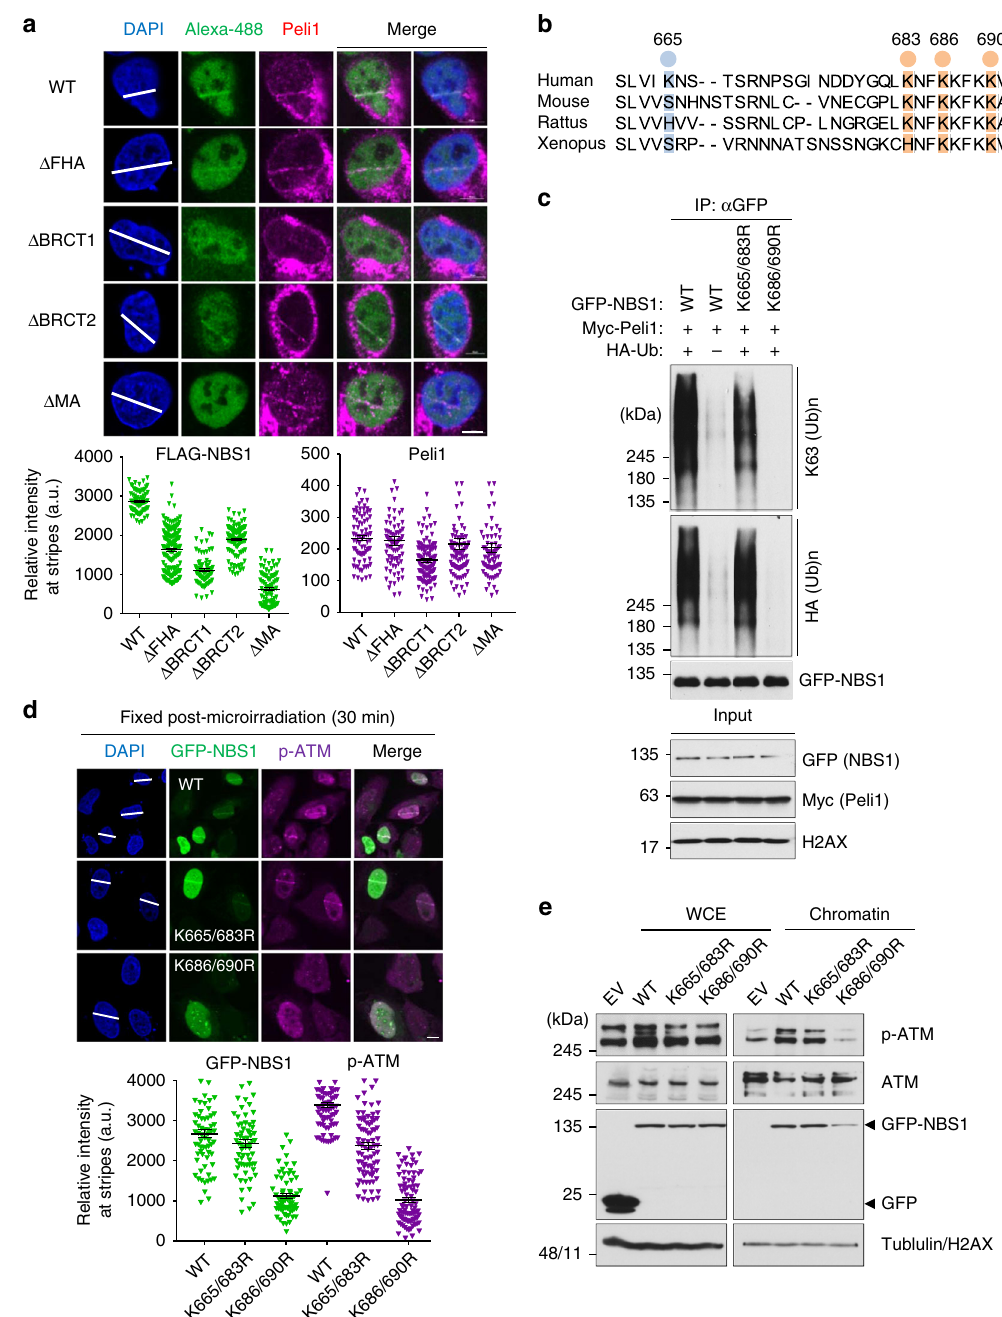
Fig. 7 Peli1 ubiquitinates NBS1 at lysine 686 and 690 that regulate NBS1 and active ATM retention at damaged sites. a FLAG-NBS1 WT and truncated mutants were transfected into U2OS cells. At 48 h post transfections, cells were microirradated and fi xed at 30 min post micro-irradiation. Recruitments of Peli1 and FLAG-NBS1 constructs were evaluated with anti-FLAG and anti-Peli1 antibodies (upper panels). Quantitative analysis of FLAG-NBS1 constructs and Peli1 at laser stripes was also performed. The intensity of each constructs at laser stripes was determined by averaging values from 20 cells and graphed (lower panels). Scale bars, 10 μ m. b Comparison of conserved lysine residues of C-terminal NBS1 in eukaryotes. c 293T cells were transfected with GFP-NBS1 WT and lysine-dead (K665/683R and K686/690R) mutants in combination with Myc-Peli1 WT and HA-Ub. Immunoprecipitated NBS1 with anti-GFP antibody was detected with anti-HA and anti-K63 antibodies. d Cells transfected with GFP-Peli1 WT, K665/683R, and K686/690R mutants were subjected to micro-irradiation at 24 h post transfection with endogenous NBS1 3 ′ -UTR-targeting siRNA. At 30 min post micro-irradiation, micro-irradiated cells were fi xed and immunostained with anti-p-ATM antibody (upper panels). Quantitative analysis of GFP-NBS1 constructs and p-ATM at laser stripes was also performed. The intensity at laser stripes was determined by averaging values from 20 cells and graphed (lower panels). Scale bars, 10 μ m. e 293T cells were transfected with GFP-NBS1 WT, K665/683R, or K686/690R mutants. At 48 h post transfection, DSB-mimetic drug phleomycin (50 μ g/ml) was used to treat cells. After washing out, whole cell extracts and chromatin fraction were collected 30 min later. Indicated antibodies were used to detect